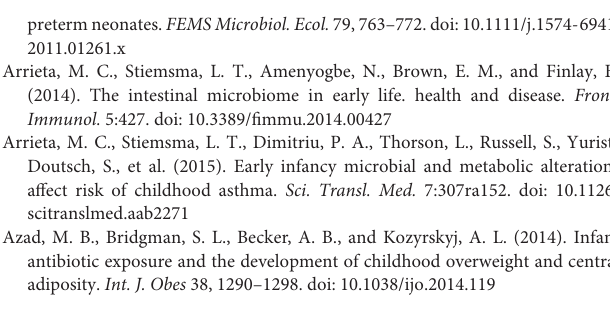
TABLE S4 | Significant differences in the gut microbiota composition between genders as determined by